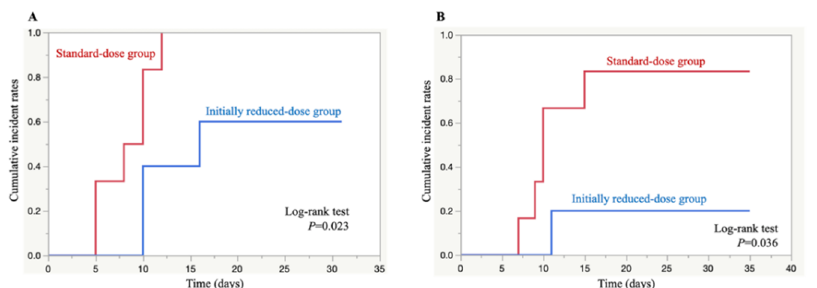
Figure 1. Kaplan–Meier curves of thrombocytopenia ( A ) and severe thrombocytopenia ( B ) devel- opment time after the initiation of linezolid therapy in the standard-dose group (red) and initially reduced-dose group (blue).